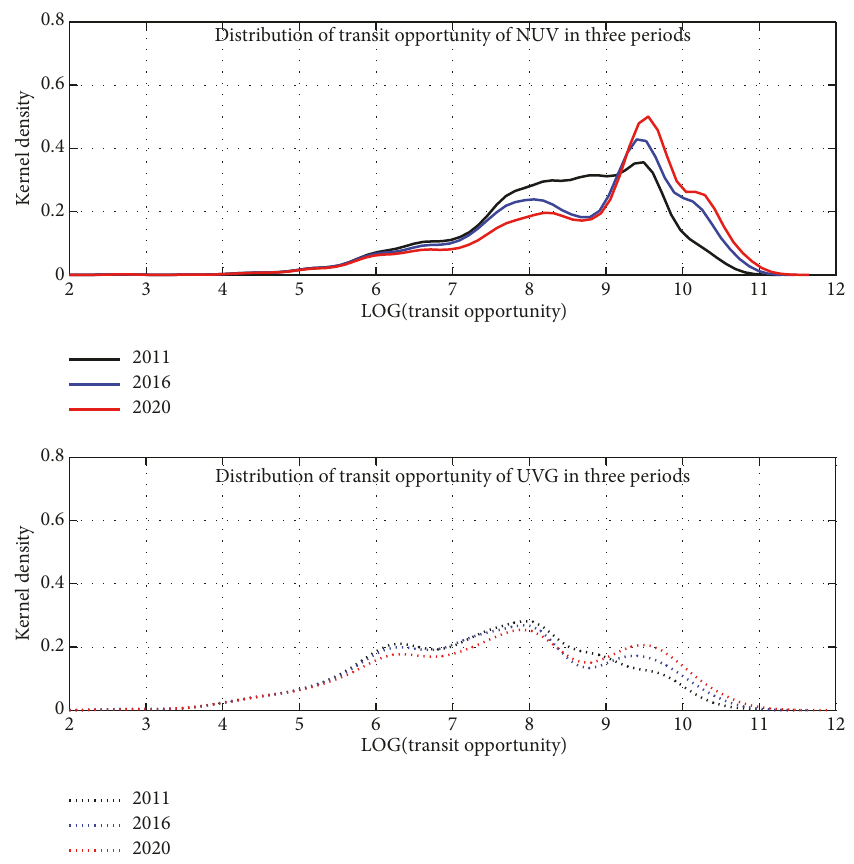
Figure 4: Distribution of transit opportunity probability of NUV and UVG